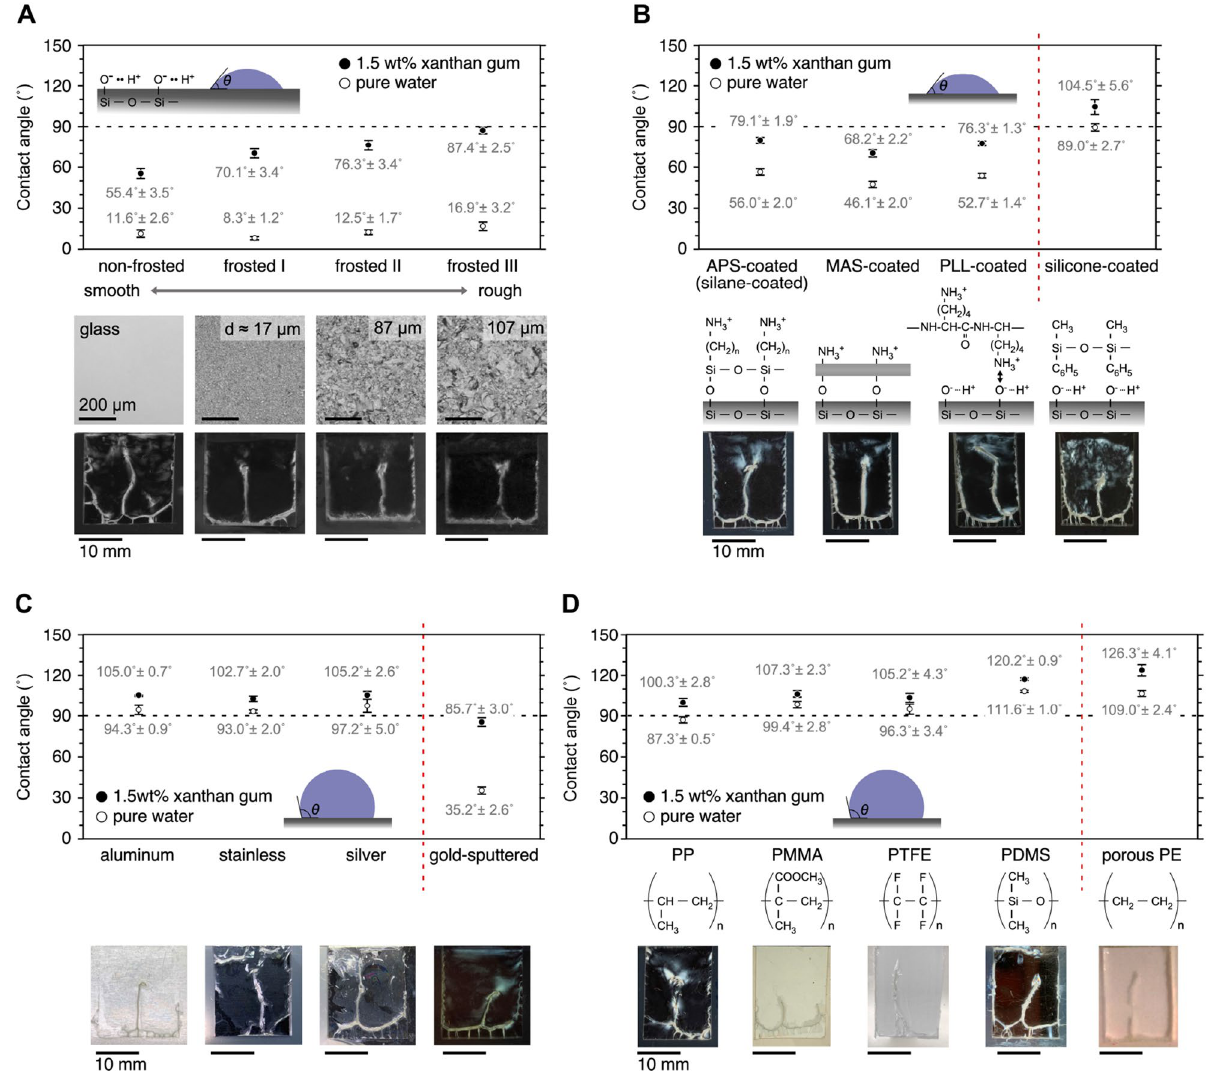
Figure 4. Macro-space partitioning on various kinds of substrates having hydrophilic/hydrophobic surfaces. Frosted glass ( A ), functional-molecules-modified glass ( B ), metals ( C ), and plastics ( D ). Contact angles on substrate for pure water and 1.5 wt% XG aqueous solution at 25 °C. Inner dimensions of the cell: (X-width, Y-thickness, Z-depth) = (15–20 mm, 1 mm, ~ 20 mm). Initial polymer concentration: 1.5 wt%. Drying temperature: 60